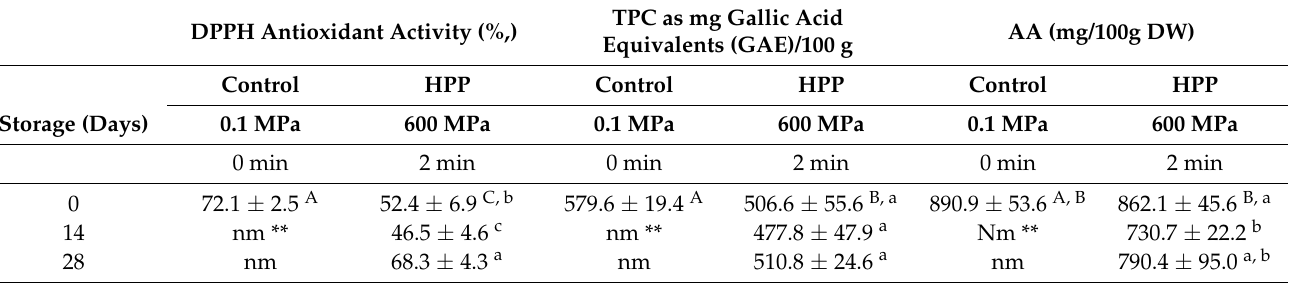
Table 5. DPPH antioxidant activity (%,), total phenolic content (TPC) expressed as mg gallic acid equivalents (GAE)/100 g DW and content of ascorbic acid (AA) (mg/100g DW) of cauliflower measured before (control) and after HPP